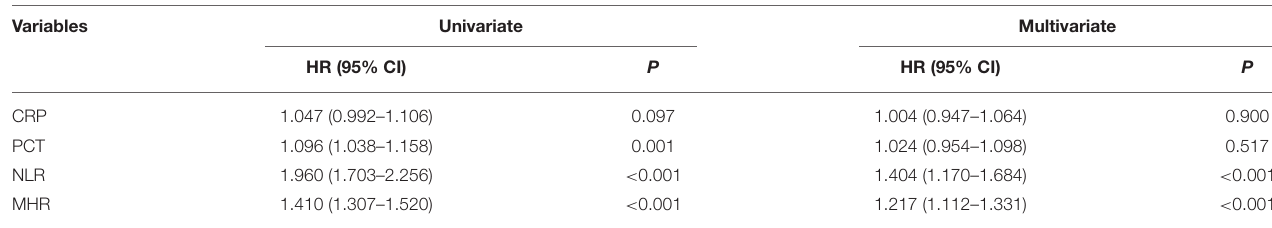
TABLE 2 | Hazard ratio of predictors in univariate and multivariate Cox regression.